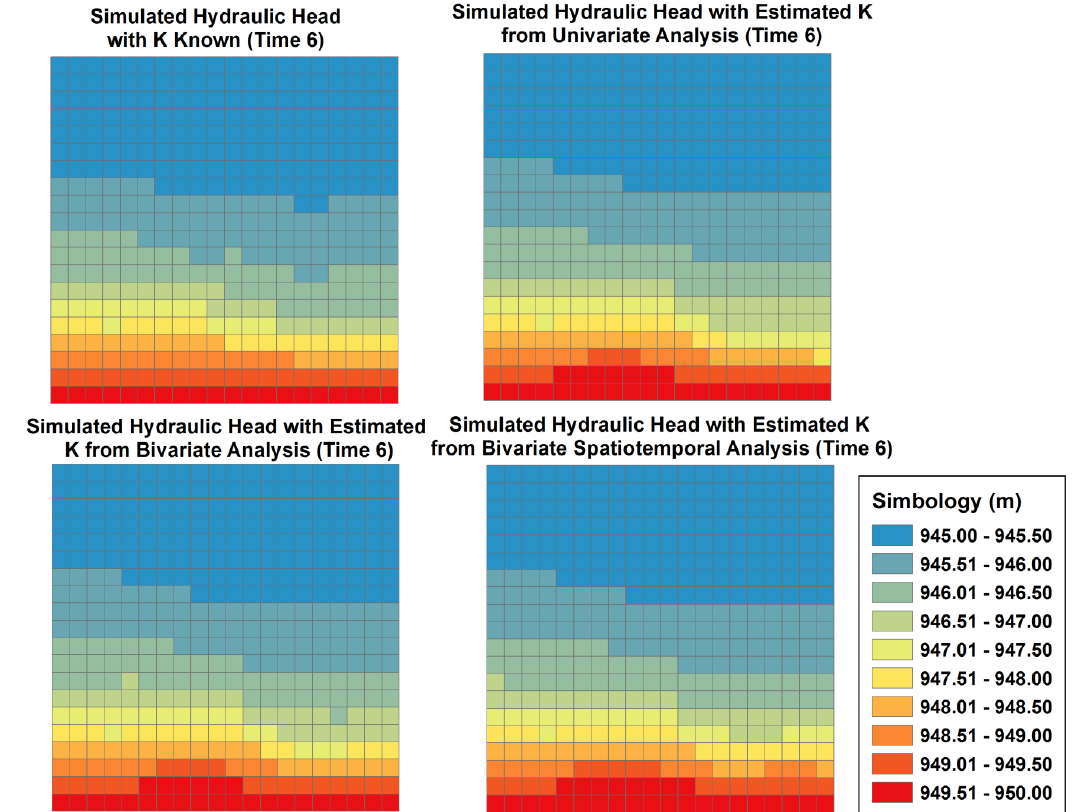
Figure 7. Simulated hydraulic head spatial configurations.